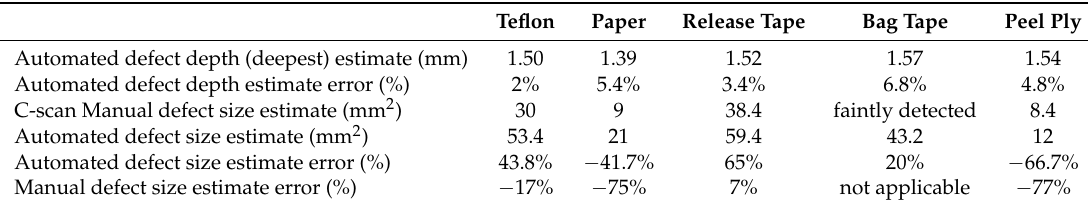
Table 1. Size and depth estimation of different types of defects with the size (6 × 6 mm) at the design depth 1.47 mm in the reference standard specimen.